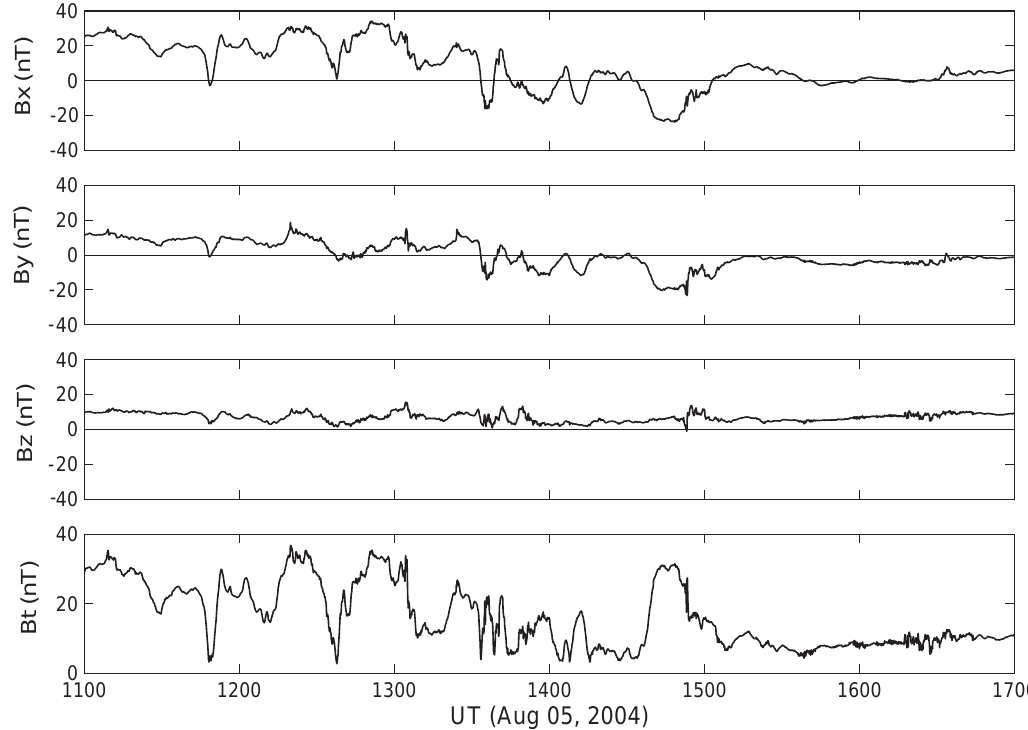
Figure 1a. Cluster magnetic field in GSM coordinates. Note the neutral sheet crossings starting around 1200 UT.